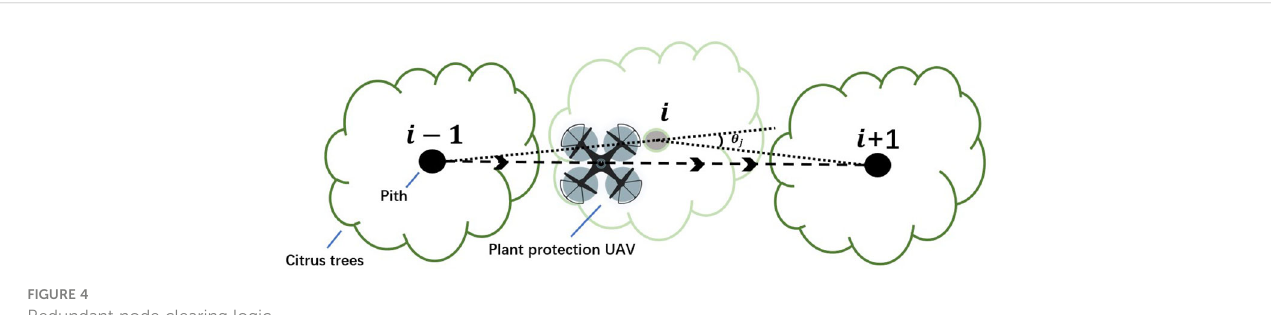
FIGURE 4 Redundant node clearing